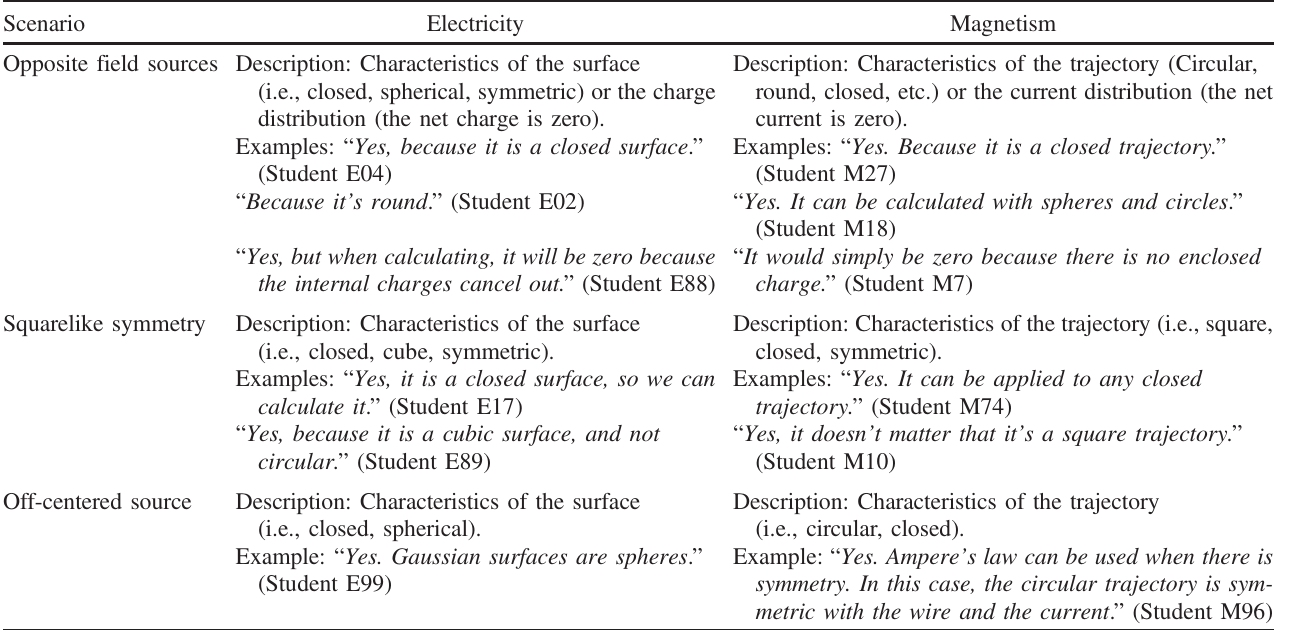
TABLE IV. Description and examples of student ’ s reasoning in the category surface features permit for each scenario. Scenario Electricity Magnetism Opposite field sources Description: Characteristics of the surface